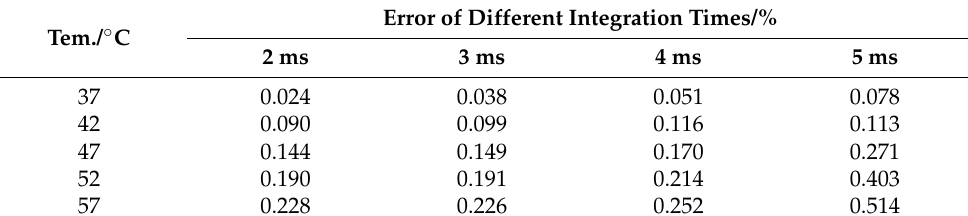
Table 7. The errors of different integration times between the ECCF method and the NES method. Tem./°C